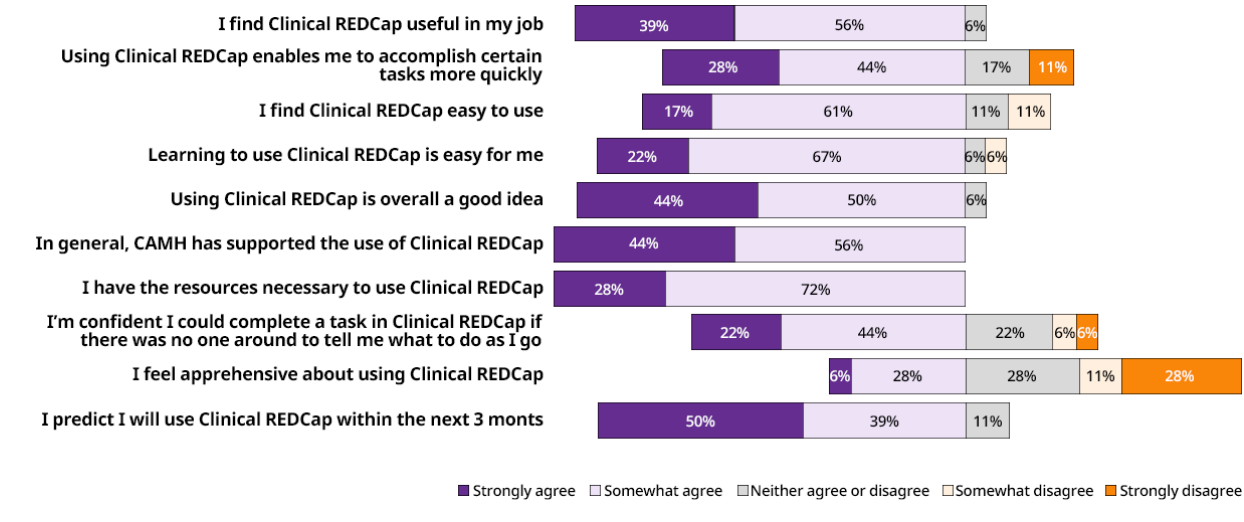
Figure 5. Clinical REDCap user acceptance questions and responses. CAMH: Centre for Addiction and Mental Health; REDCap: Research Electronic Data